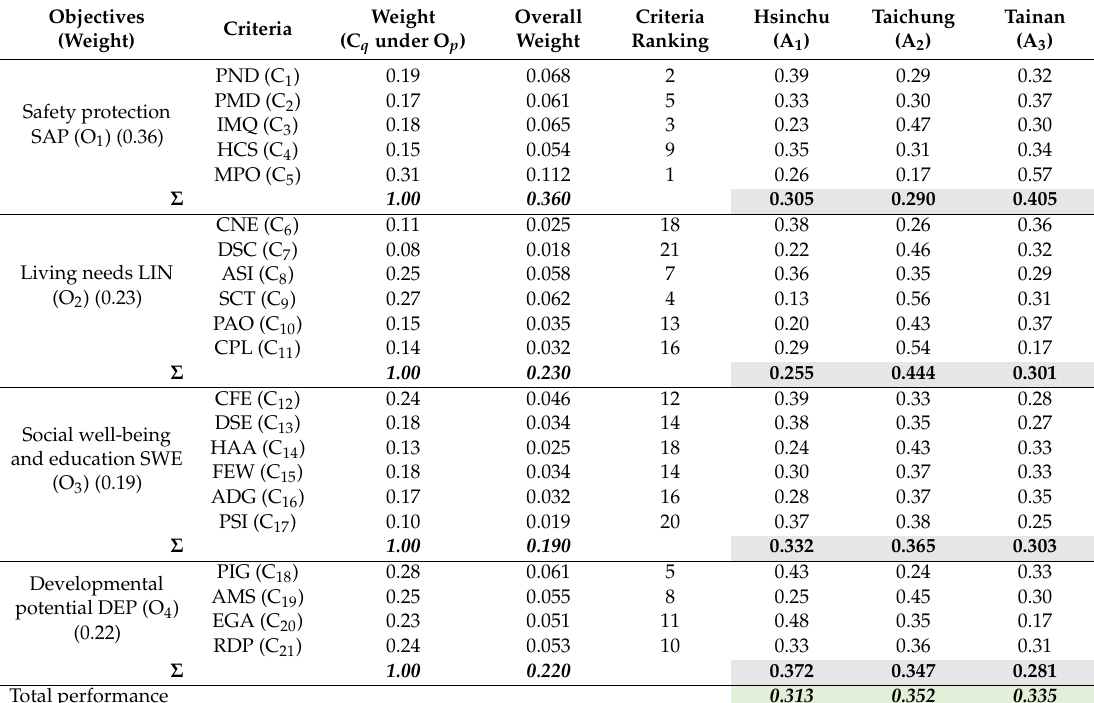
Table 9. The overall evaluation